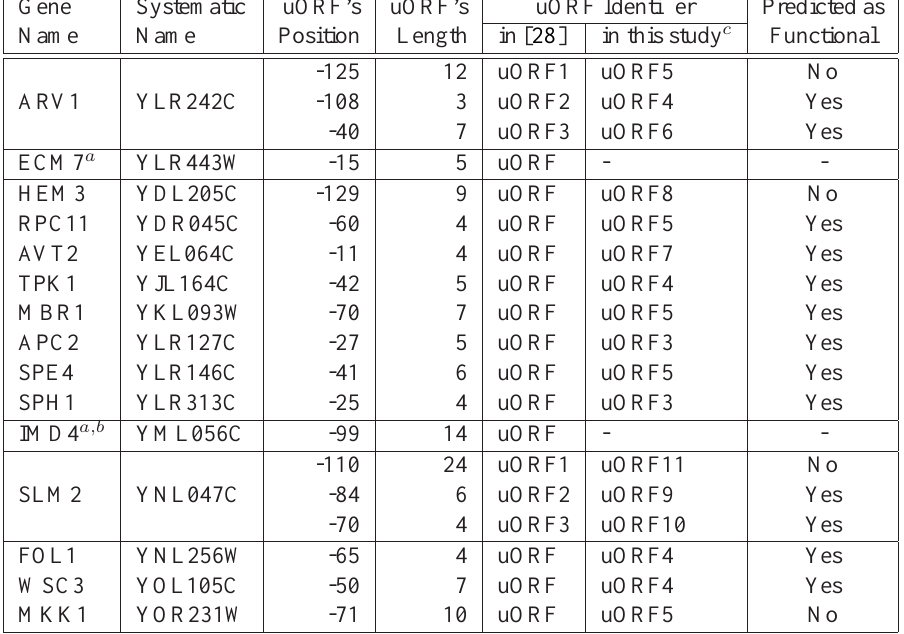
Table 7: Predictions made using the model in Figure 4 for the 15 genes reported by Zhang and Dietrich [28].